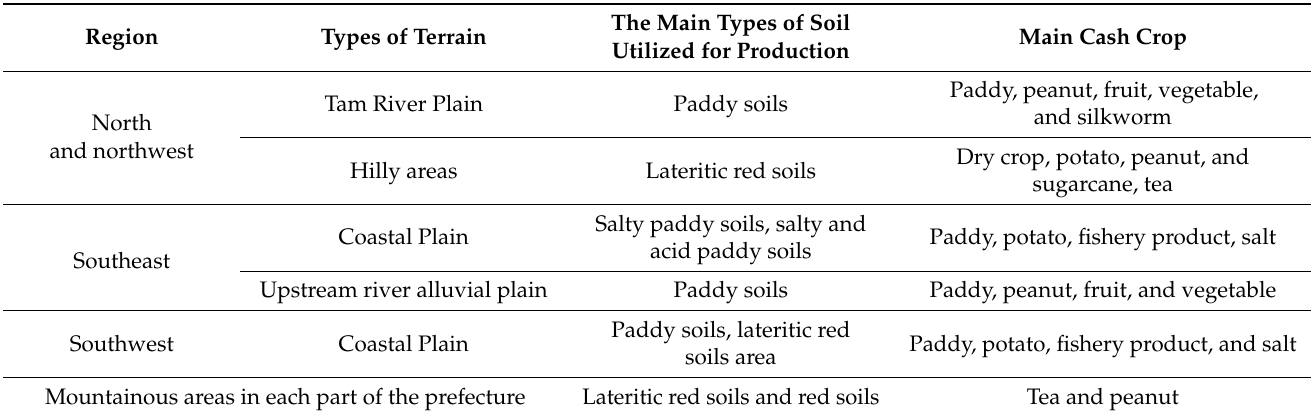
Table 3. The main types of soil utilized for production and economic